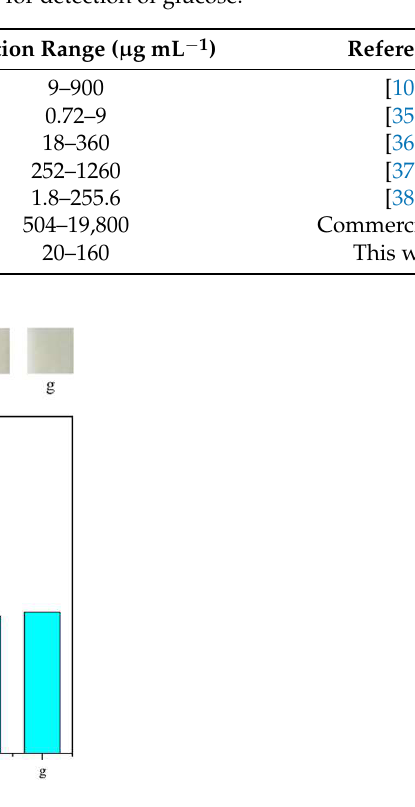
Figure 8. Selectivity of the developed method for glucose: ( A ) color results; ( B ) statistical results. a: glucose; b: glycine; c: mannitol; d: sarcosine; e: creatinine; f: vitamin C; g: sucrose.